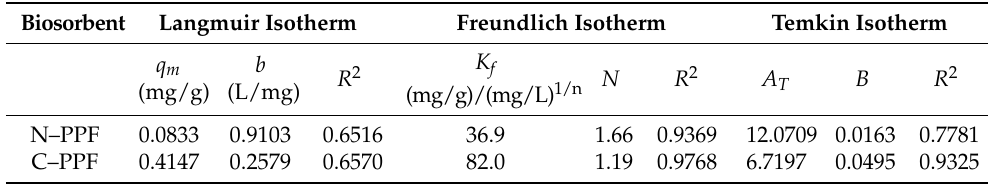
Table 3. Comparison of isotherm parameters for Fe(III) adsorption on C–PPF and N–PPF